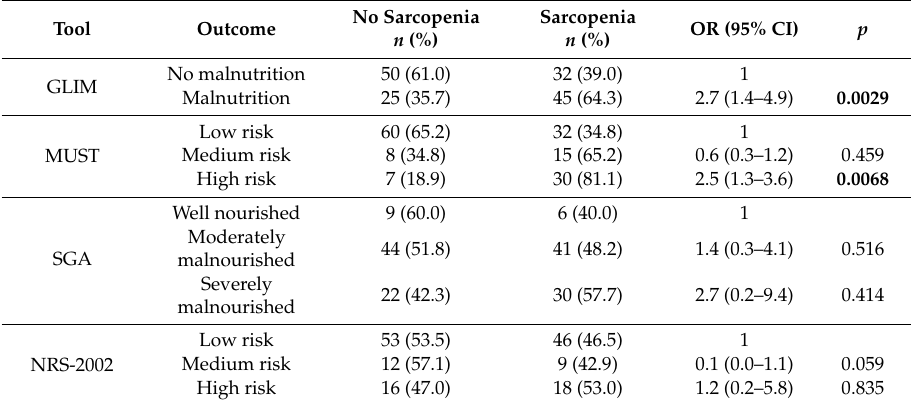
Table 4. Association between nutritional status and presence of sarcopenia on